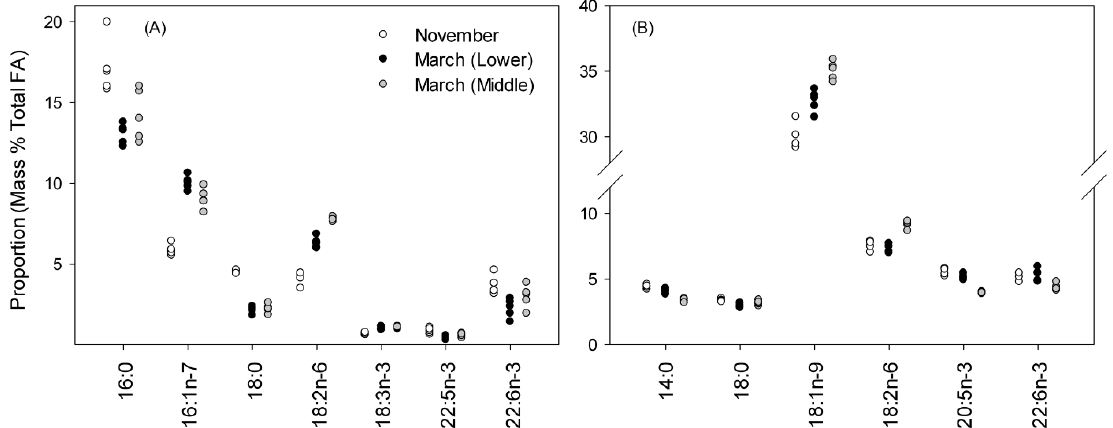
Figure 2. Proportions of fatty acids (FA) making greatest contributions to differences among samples in triacylglycerol of ( A ) liver ( n = 5) and ( B ) muscle ( n = 5 ). For the liver, within each FA, November samples are significantly different (Tukey’s test; p < 0.05) than all other samples for all FA except 22:6n-3, where the November samples are only different from the March (Lower pond) samples. In the muscle, FA proportions were different for all sampling times for 14:0, 18:1n-9, and 20:5n-3. For 18:0, November and March (Lower pond) were different; for 18:2n-6 and 22:6n-3, March (Middle pond) was different from both November and March (Lower pond).